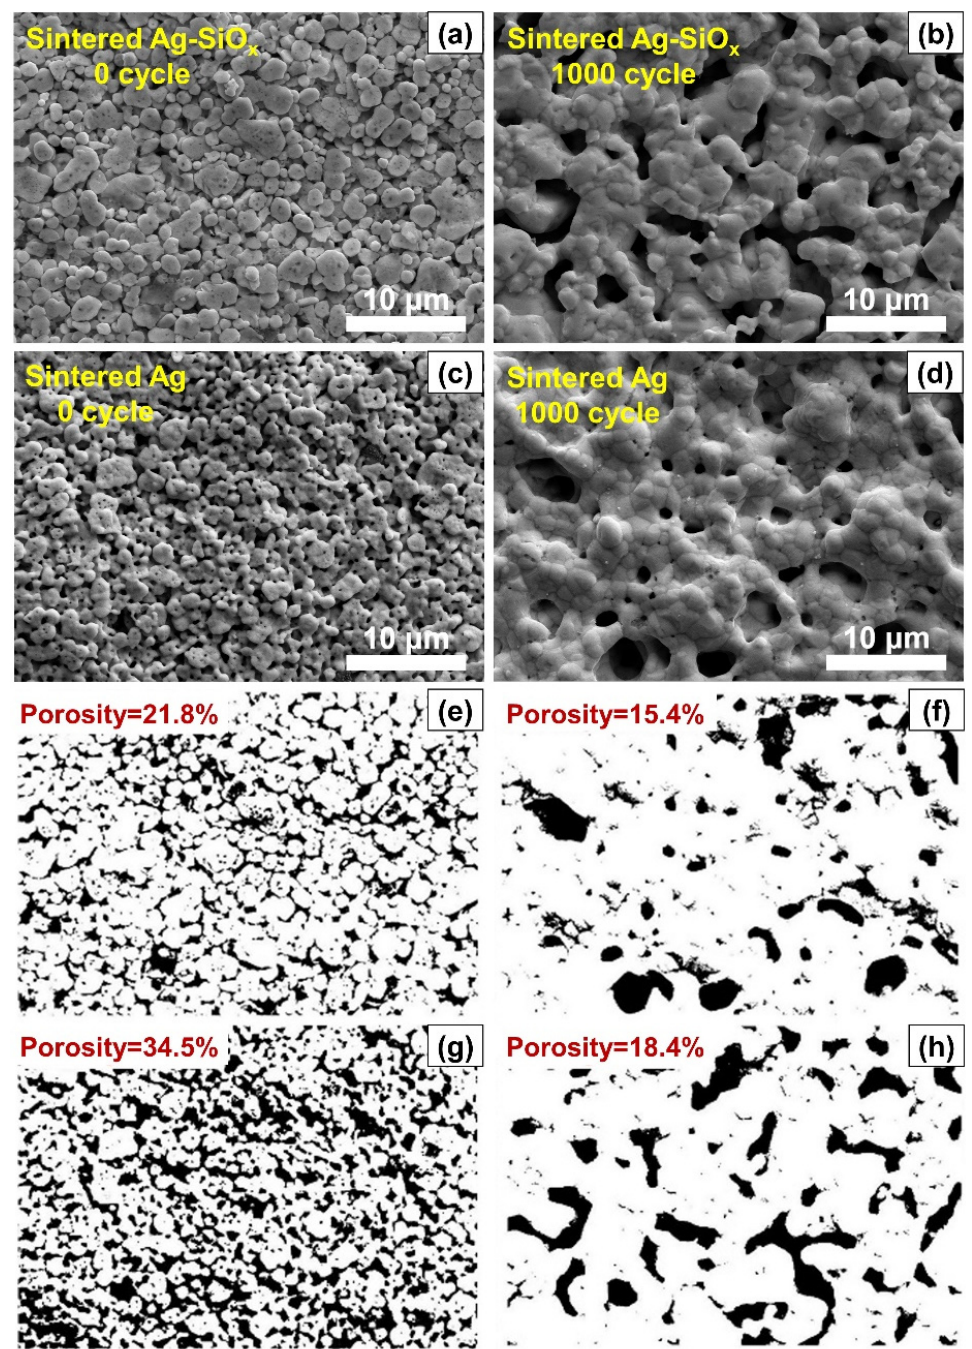
Figure 4. ( a – d ) Microstructures and ( e – h ) porosity comparisons of sintered nano-Ag and sintered nano-Ag-SiO x before and after the thermal shocking test.